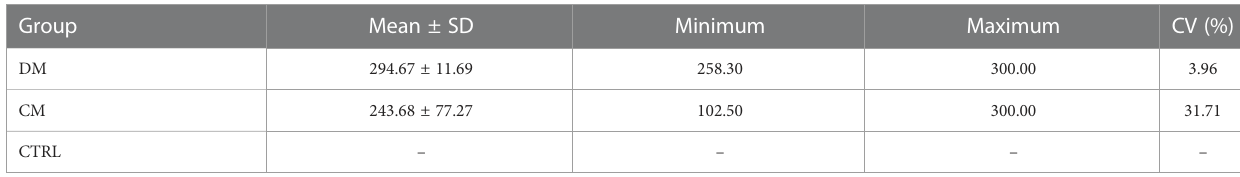
SD, standard deviation from the mean; CV, coef fi cient of